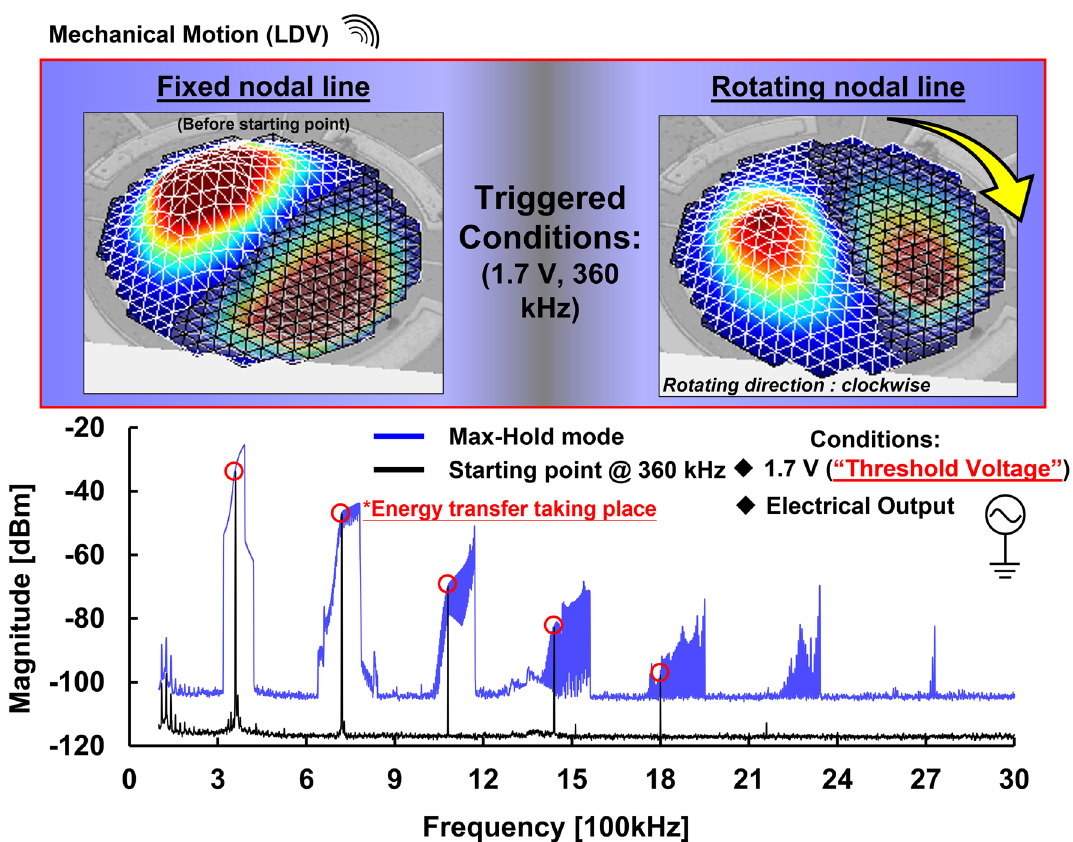
Figure 5. Validation of energy transfer in rotating nodal line of nonlinear MEMS resonator: To explore the energy transfer between two nonlinear energy states, electrical measurement of frequency sweep with a threshold voltage of 1.7 V was performed to be compared with a single tone driving signal at 360 kHz where the rotation takes nonlinear behaviors such as the generation of higher-order harmonics can be observed in the electrical meas- urement through the integrated inner electrodes. As a result, the motion of f 0 is normal (1,1) mode and most of the other coherent integer frequencies are harmonic motions induced by the higher-order stiffness of the resonator. Instead of the nonlinear behavior regarding the generation of higher-order harmonics, the motion of 3 f 0 is normal (1,2) mode, which is excited by higher-order harmonics of driving frequency f 0 , caused by another nonlinear behavior regarding the parametric effect. In order to study the mechanical rotation by a single-tone driving signal, a higher driving voltage of 3 V is used to drive the resonator into the next nonlinear state actuat- ing the rotating nodal line. The mechanical motions were also captured by LDV and presented in Supplementary Video. 3. Compared to the measurement result of lower voltage driving, all motions, including normal (1,1) mode, normal (1,2) mode caused by the parametric effect, and other harmonic modes, are rotating. According to the measurement results, there is still a threshold voltage required for nonlinear mechanical rotation motion in the case of a single-tone drive. The final validation of mechanical rotation motion under single-tone driving is on whether the rotation frequency band exists or not. To identify the different energy states, two frequencies: (a) 353 kHz (out of the rotation frequency band) and (b) 361 kHz (within the rotation frequency band), are used to drive the resonator into a strong nonlinear state for comparison. The mechanical motions were also captured by LDV and presented in Supplementary Video. 4. While driving at 361 kHz (in-band), mechanical motions of the coherent integer fre- quencies are all rotating. In contrast, while driving at 353 kHz (out-of-band), mechanical motions of the coherent integer frequencies only show the Eigen and harmonic motions without rotation. Figure 7 shows all the motions and displacement results by these two driving frequencies. According to the optical measurements by LDV, there still exists a rotation frequency band for the nonlinear mechanical rotation in the case of a single-tone drive. The mechanical rotation motion provides a radiation force in the medium and shows great potential as a unit of angular momentum. The technology of micromanipulation, implemented with the angular momentum cell, has been actively investigated in microfluidics, biomedical MEMS, and powder fabrication processes. Small parti- cles in the field of fluidics and acoustics can be captured and separated by using this technology 27,28 . These poten- tial applications can utilize this mechanical rotation mechanism for contact-free manipulation of particles or for generating a stable rotation torque. Through the controllable and predictable trigger conditions validated in this work, this technology will be promising and attractive to be implemented in the abovementioned applications.